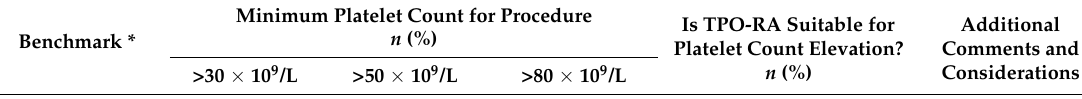
Table 2. CEHC Initiative Group consensus recommendations for managing TCP in patients with CLD scheduled for an invasive